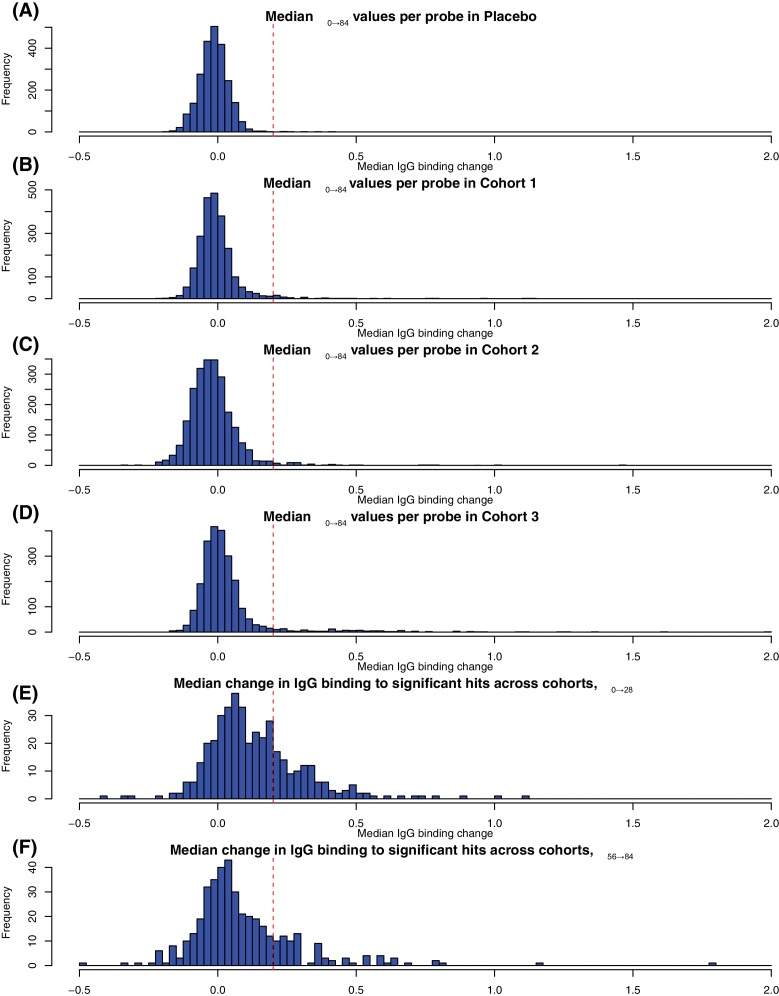
Determining the threshold for identifying substantial changes in IgG binding between timepoints.The first four histograms in panels (A–D) show the distribution of Δ0→84 values across all probes for the four cohorts in the trial. The threshold of 0.2 separates the main distribution of small Δ0→84 values from the outliers associated with immunogenic proteins in the WCV. This threshold is marked on Figure 3. The last two histograms in panels (E-F) show the distribution of changes in IgG binding between the (E) first two (Δ0→28) and (F) last two (Δ56→84) timepoints for the individuals in the vaccinated cohorts in whom all four timepoints were sampled. Only probes identified as undergoing a significant change based on the eBayes or LMM analyses were included in the plots, resulting in an enrichment of larger changes in IgG binding. Based on these, the same threshold of 0.2 units was selected as distinguishing the set of probes detecting a change in the specified interval from those detecting changes over other time periods. This threshold is marked on Figure 7.